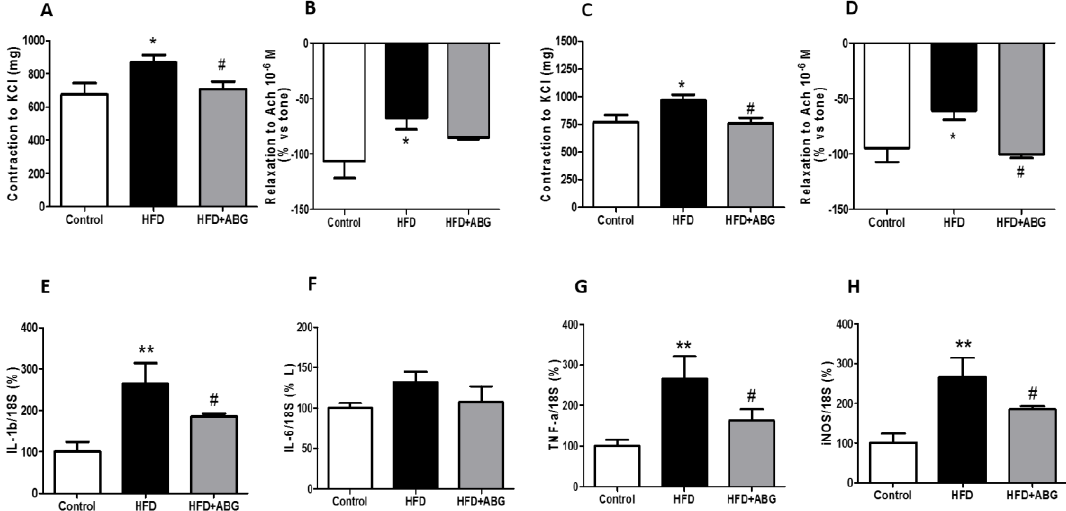
Figure 8. Vascular response of thoracic aortic rings to KCl (100 mM) and acetylcholine (10 − 6 M) in absence ( A , B ) or presence ( C , D ) of perivascular adipose tissue and mRNA expression of interleukin -1 beta (IL-1 β ) ( E ), interleukin-6 (IL-6) ( F ), tumor necrosis factor-alpha (TNF- α ) ( G ) and inducible nitric oxide synthase (iNOS) ( H ) of rats fed a standard chow (control) or a high-fat diet (HFD)/high-sucrose diet and treated with vehicles or HFD + ABG. Data are represented as mean ± SEM; n = 8 samples/group. * p < 0.05 vs. control; ** p < 0.01 vs. control; # p < 0.05 vs. HFD.